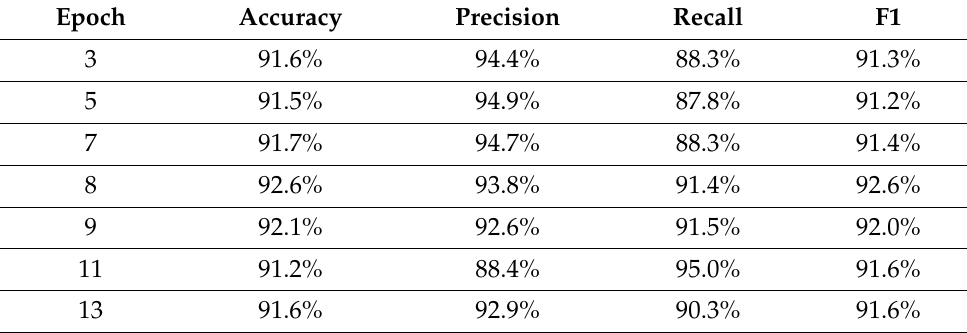
Figure 5. Experimental results of iterative experiments. Table 2. Experimental results of iterative experiments.